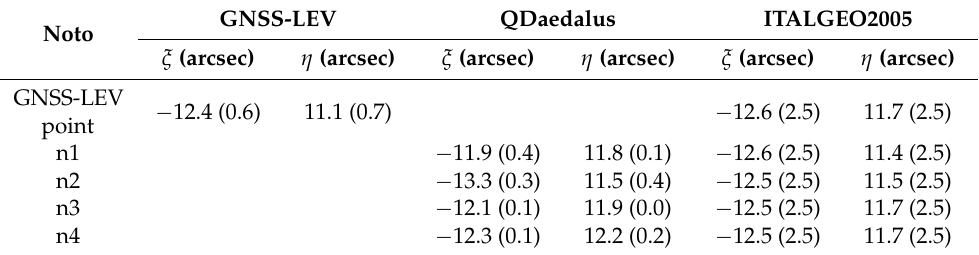
Table 2. Components of the DoV obtained by the three methods for the Noto site; standard deviations are given in